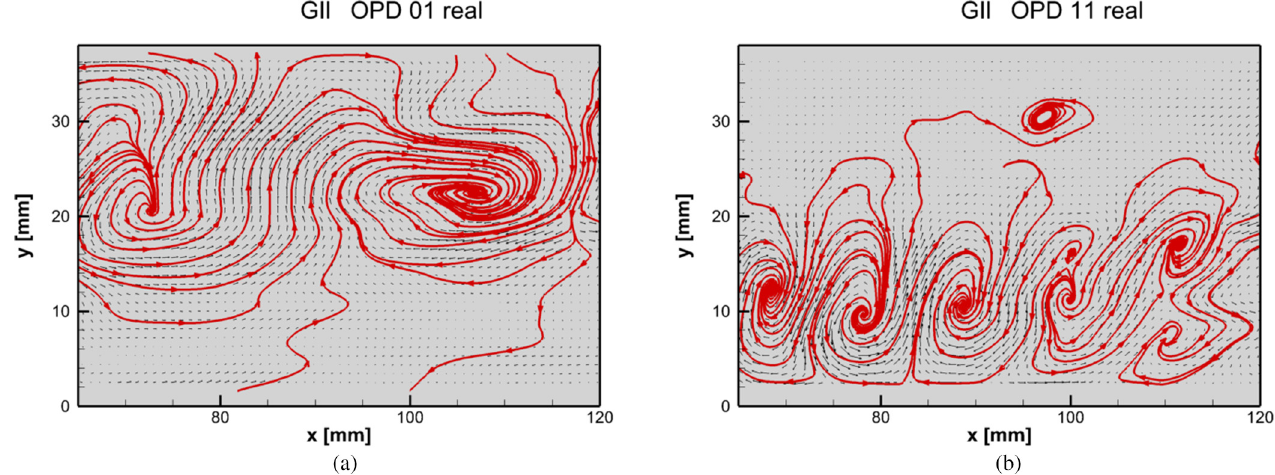
Fig. 18. Topologies of the selected OPD modes in the branch G, zone II, real parts, numbers (a) 1 and (b) 11.